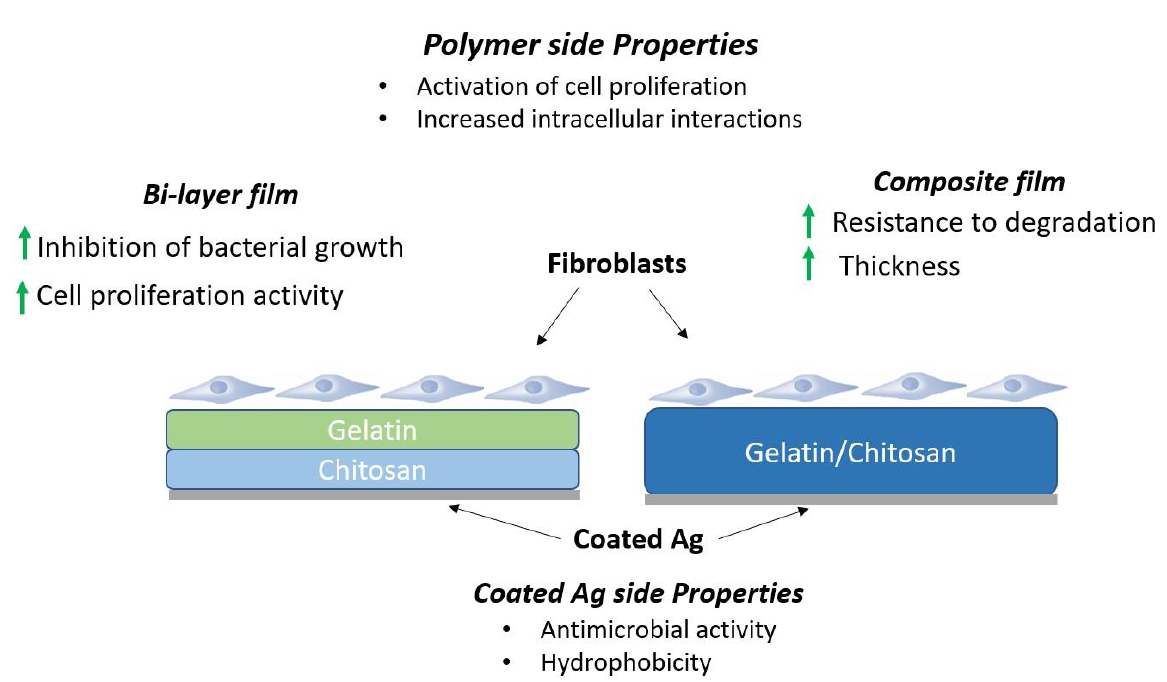
Figure 1. Graphic representation of gelatin and chitosan bi-layer and composite films with Ag coated.